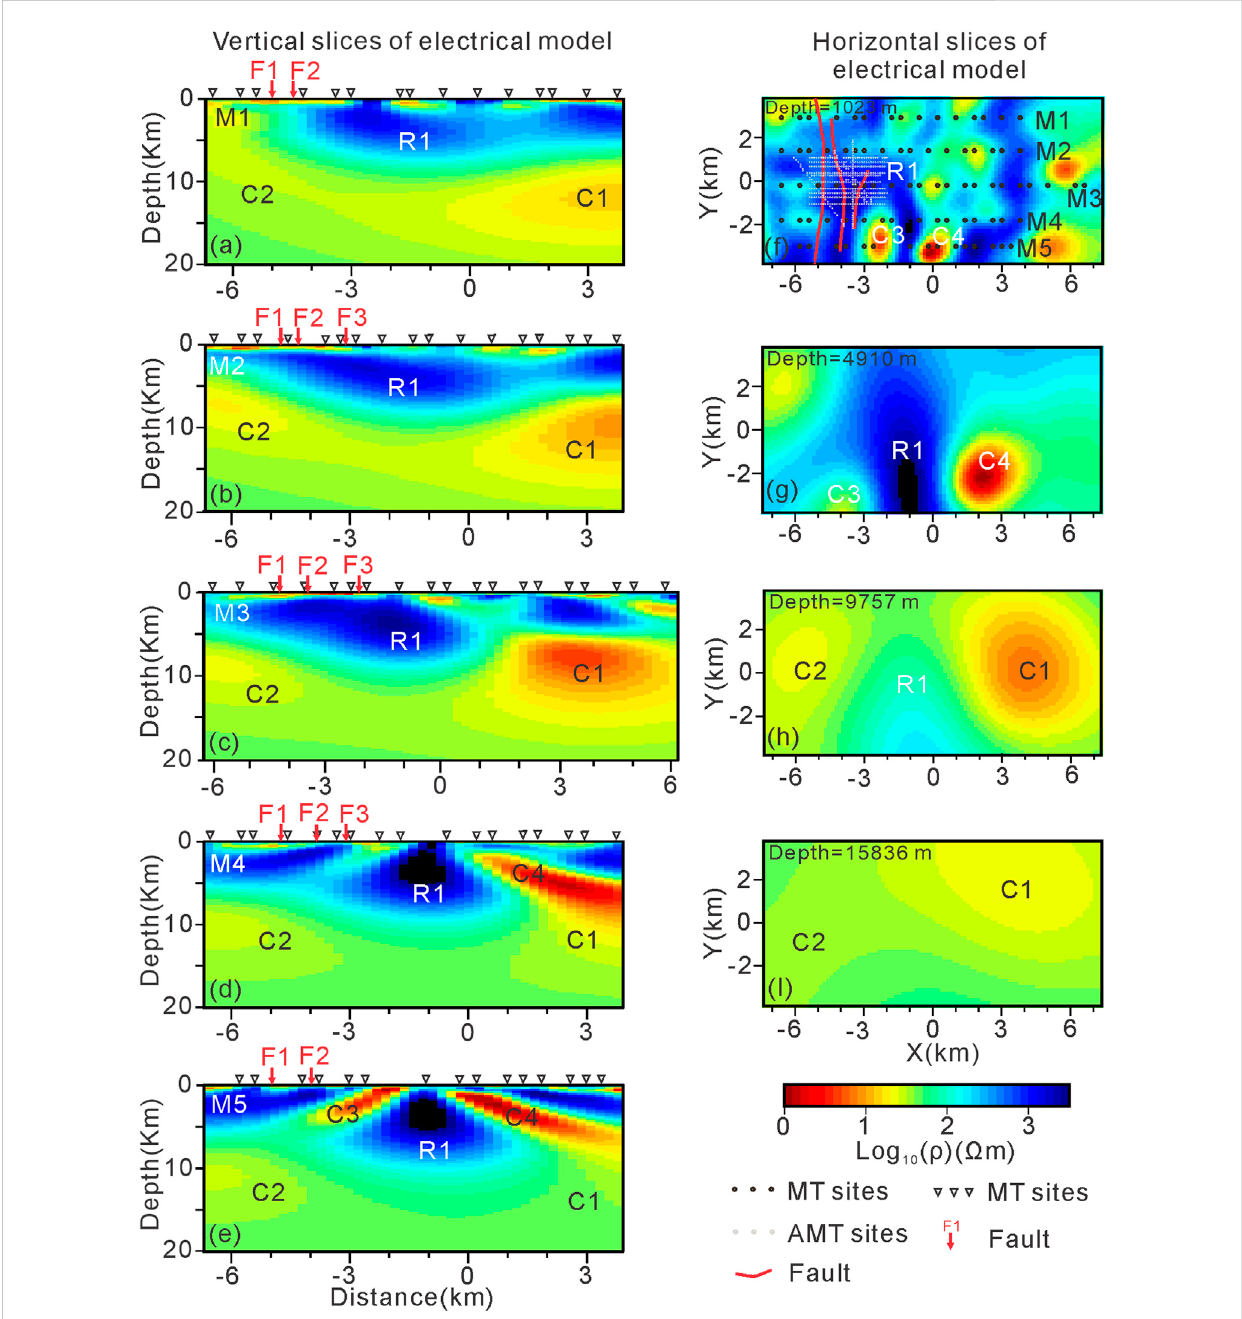
FIGURE 5 Horizontal and vertical slices of resistivity in GGF revealed by the MT. Figure (A – E) are vertical resistivity slices of M1 - M5, respectively. The vertical models are characterized by high resistivity at depth above ~8 km and high conductivity at depth below 8 km. Figure (F – I) are horizontal resistivity slices of depths at 1,028 m, 4,910 m, 9,757 m, 15,836 m, respectively. Conductors C1 and C2 dominate the electrical anomaly of horizontal models. AMT sites indicate the location of